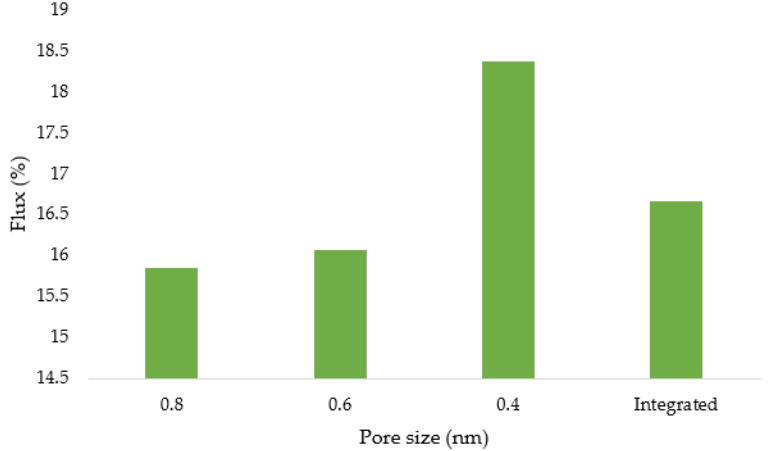
Figure 9. Concentration